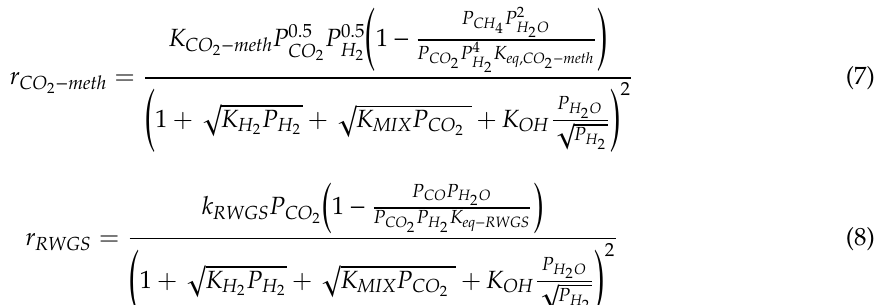
Table 6. Langmuir-Hinshelwood-Hougen-Watson (LHHW) kinetic parameters. Parameters